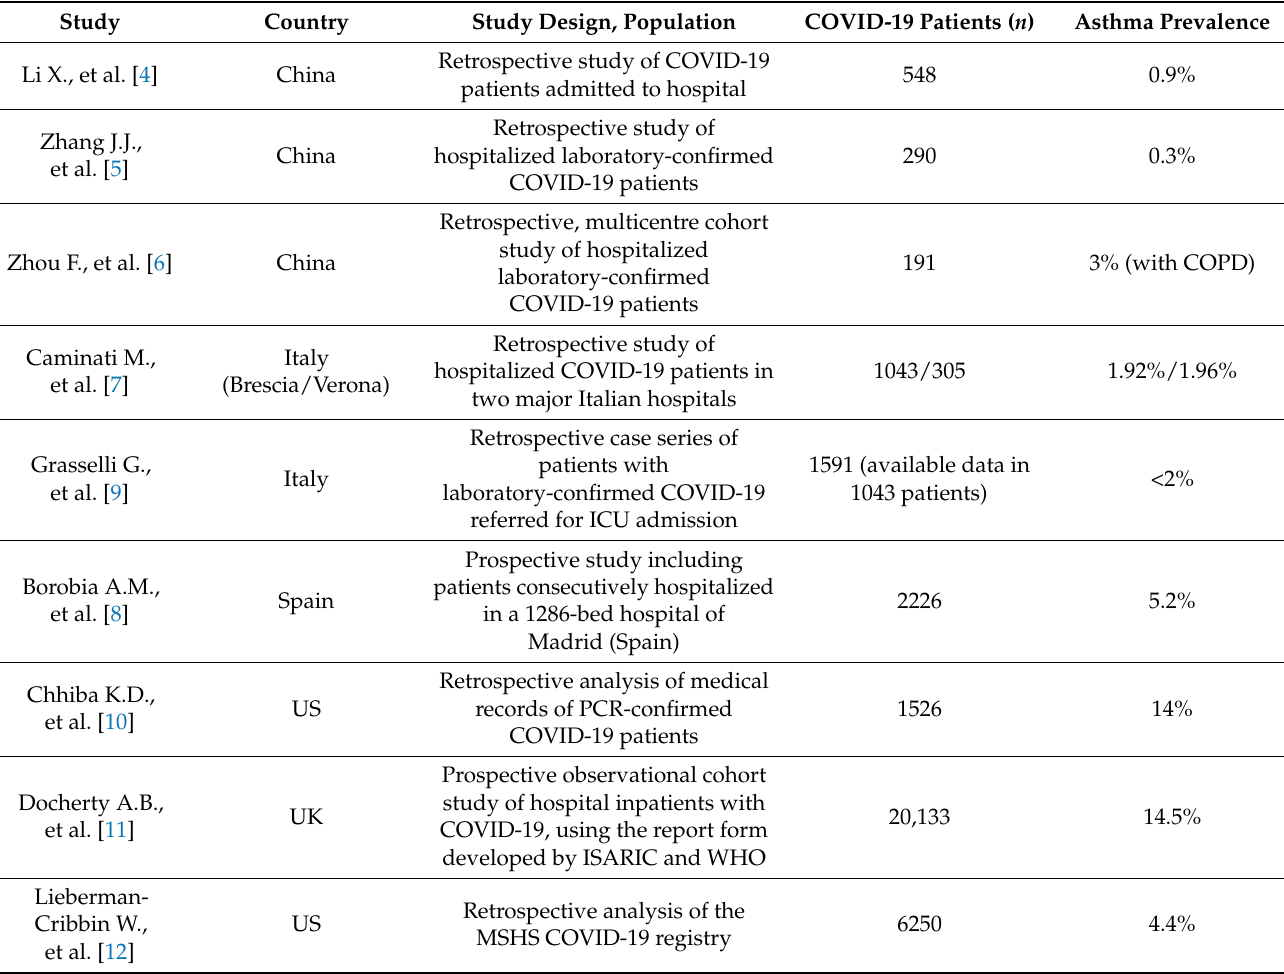
Table 1. Studies reporting asthma prevalence in